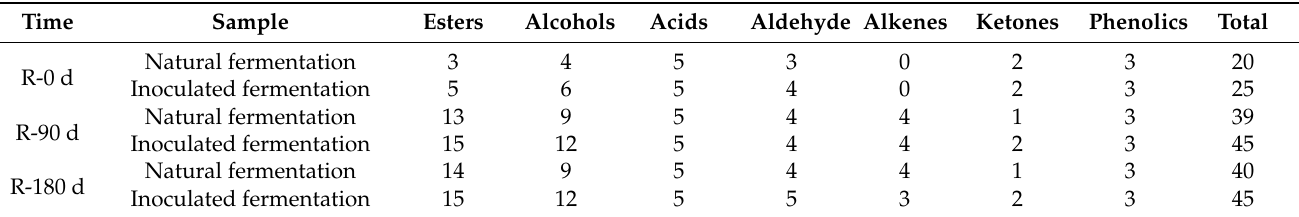
Table 6. Comparison of aroma compound types from natural and inoculated fermented